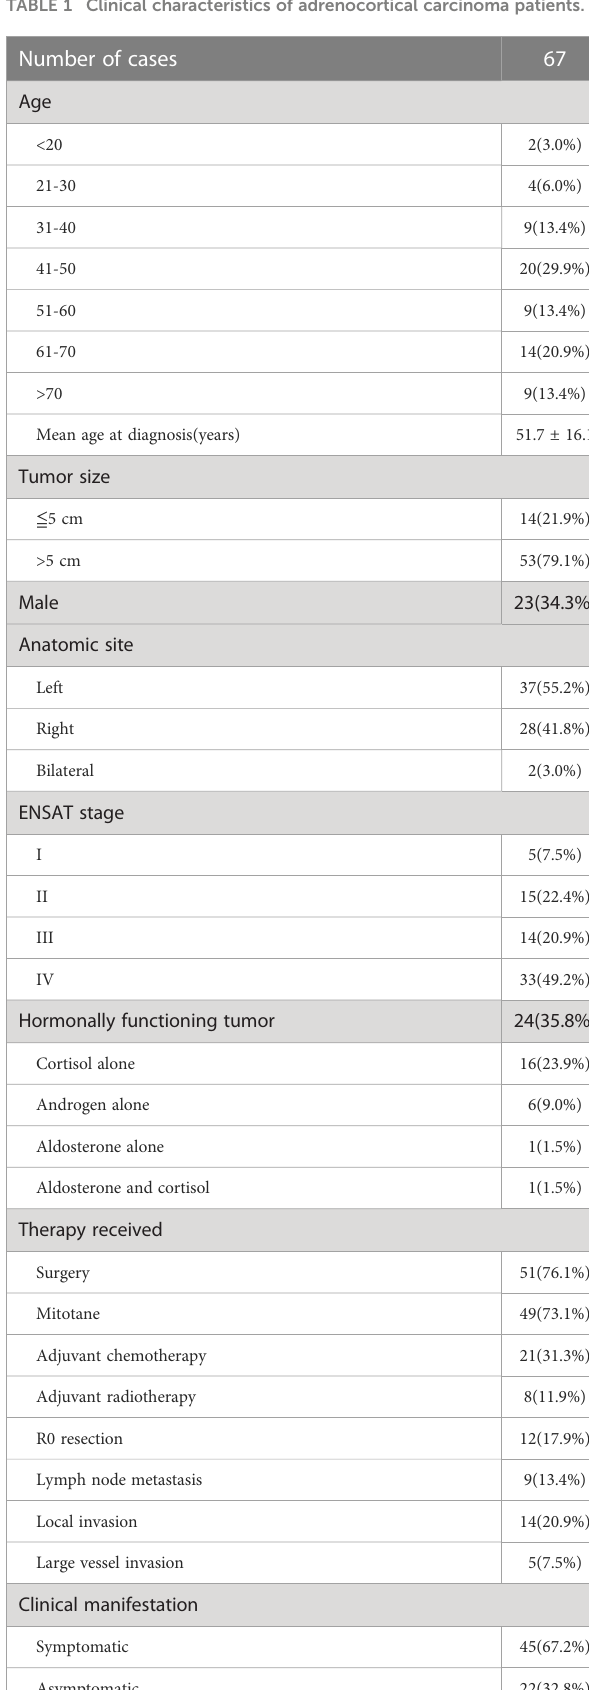
TABLE 1 Clinical characteristics of adrenocortical carcinoma